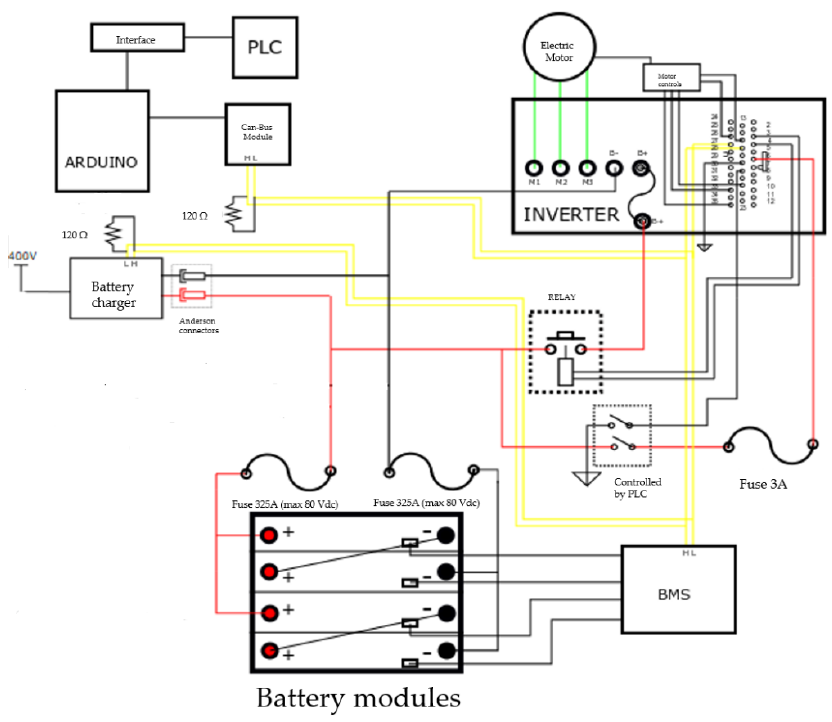
Figure 6. The overall electric schematic of the proposed e-HPS.